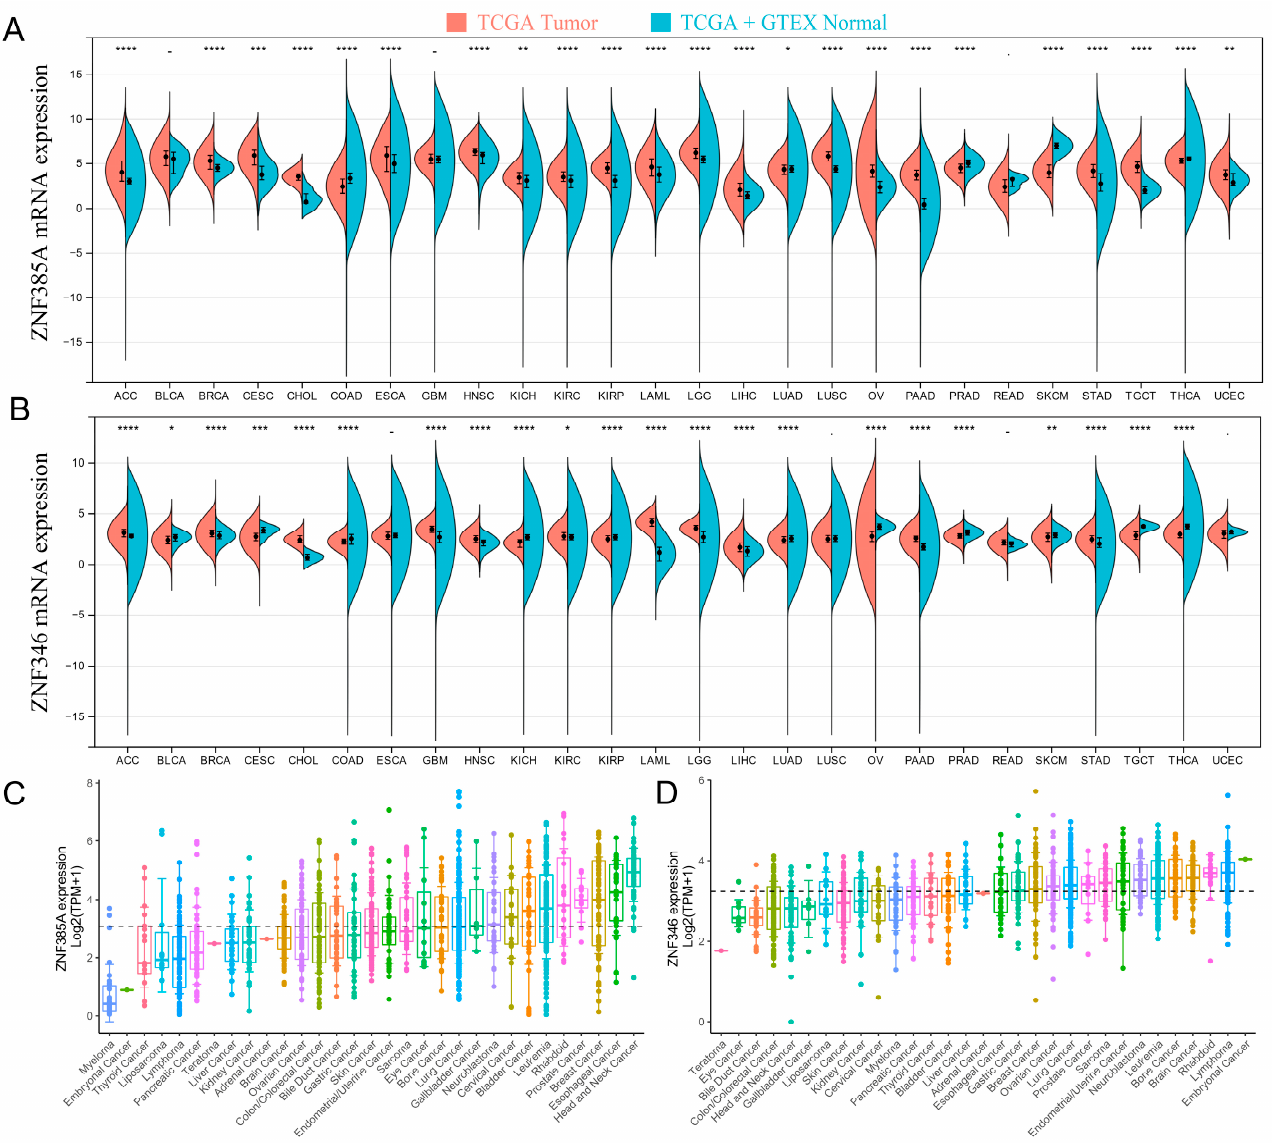
Figure 1. ZNF385A and ZNF346 expression in different types of human cancers and cell lines. ( A , B ) Increased or decreased ZNF385A and ZNF346 expression in different cancers, compared with normal tissues, by the TCGA and GTEx databases (* p < 0.05, ** p < 0.01, *** p < 0.001, **** p < 0.0001). ( C , D ) The expression of ZNF385A and ZNF346 in tumor cell lines, based on the CCLE database.